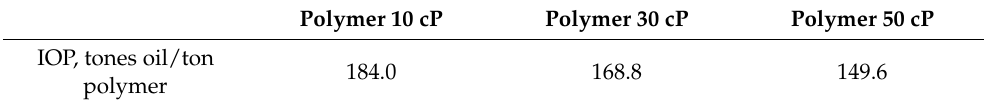
Table 4. Incremental oil production per ton of injected polymer.